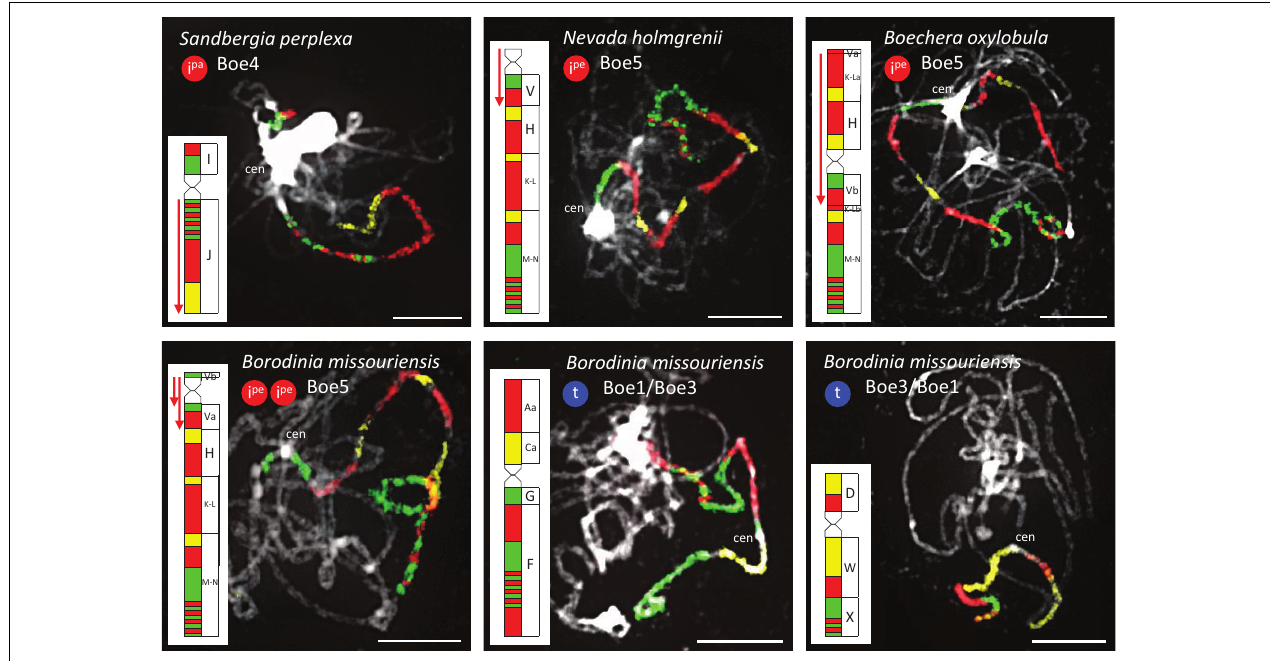
FIGURE 6 | Species- and genus-specific chromosomal rearrangements in diploid Boechereae revealed by CCP. Red downward-pointing arrows denote inverse orientation of GBs compared to their position in the ancestral Boechereae genome ( Figure 3 ). I pe : pericentric inversion; I pa : paracentric inversion; t: whole-arm translocation. Chromosomes were identified by CCP with A. thaliana BAC contigs labeled by biotin-dUTP (red flourescence), digoxigenin-dUTP (green) and Cy3-dUTP (yellow). A. thaliana BAC clones defining each BAC contig/painting probe are listed in Supplementary Tables S4, S5, S7, S8 . Chromosomes were counterstained by DAPI. Scale bars, 10 µ